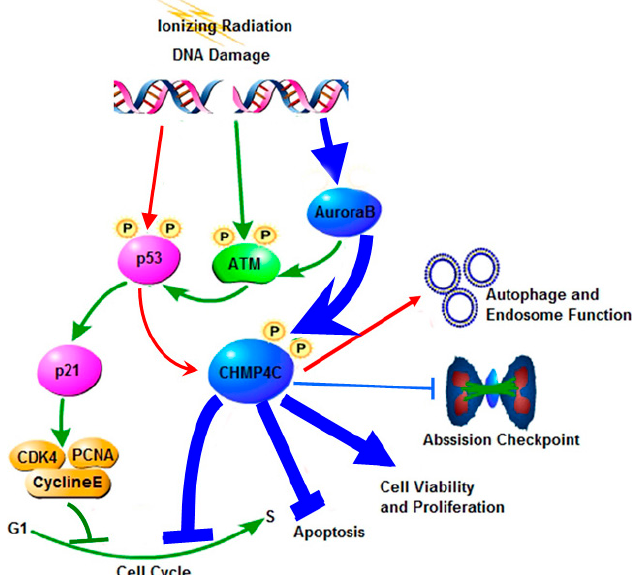
Figure 9. The summary of CHMP4C signaling in response to stress. CHMP4C is phosphorylated by Aurora B to regulate the abscission timing checkpoint and cell cycle progression, promote cell survival and cell viability and resist apoptosis (Blue arrows). The ataxia telangiectasia mutated kinase (ATM) is activated in mitosis in Aurora B-dependent manner (Green arrows). p53 transcriptionally regulates CHMP4C to enhance autophagy and endosome production (Red arrows). p21 is the target gene of p53 and functions in the G1 to S checkpoint (Green arrows).